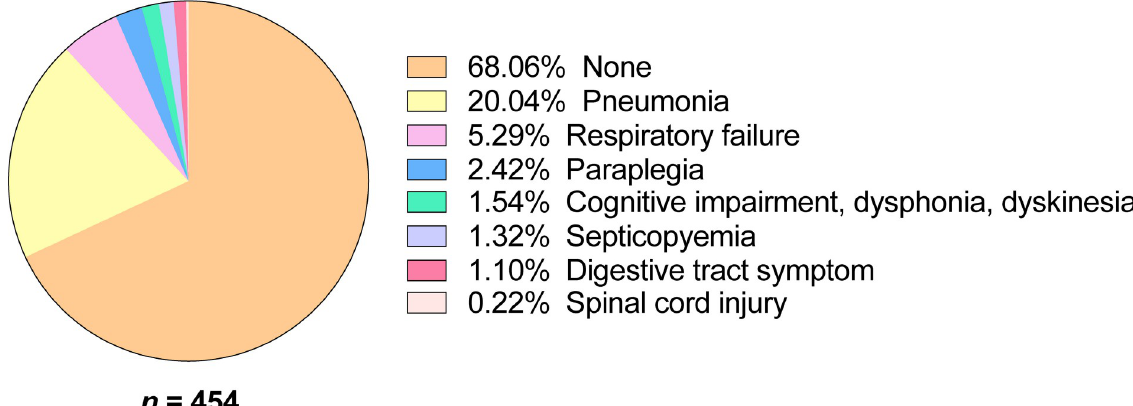
Fig 2. Distribution of complications in hospitalized children with JEV infection ( n = 454).